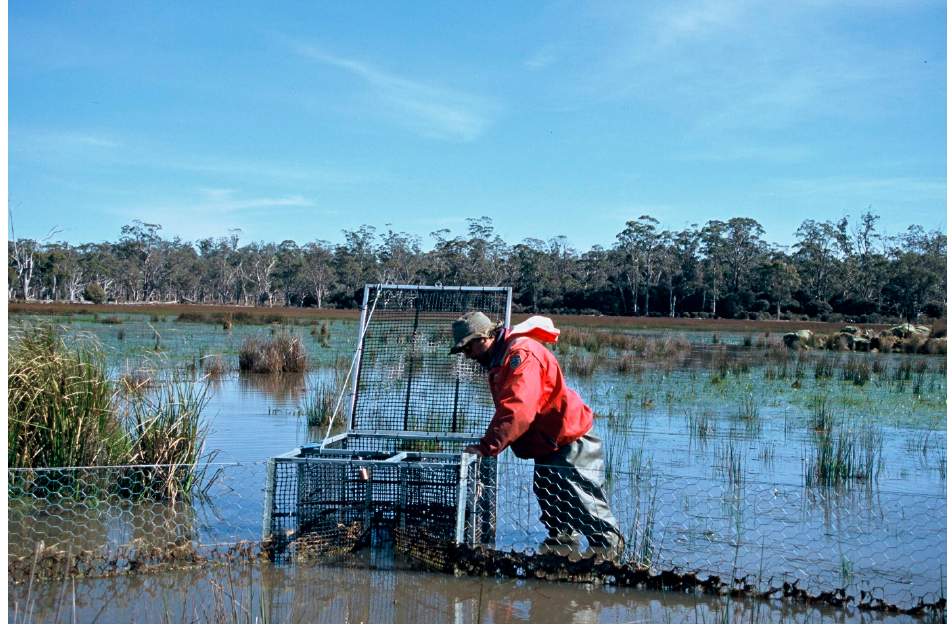
Figure 4. The wire fences that were installed to prevent carp from accessing potential spawning habitat, with lockable traps set at strategic locations. The large expanse of wetlands can be seen behind the fence and trap.